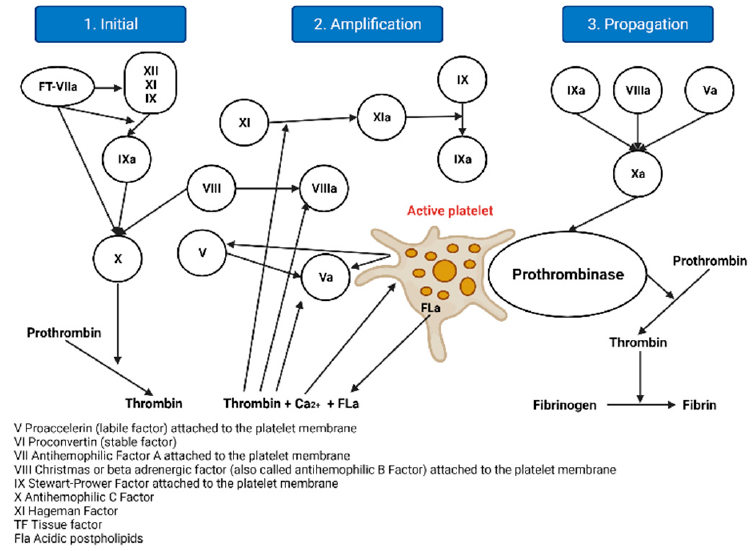
Figure 2. Current molecular model of coagulation. Note: This figure presents the current model of the coagulation cascade based on stages, created by the main author using the BioRender tool. Adapted from Sarmiento Doncel, S, et